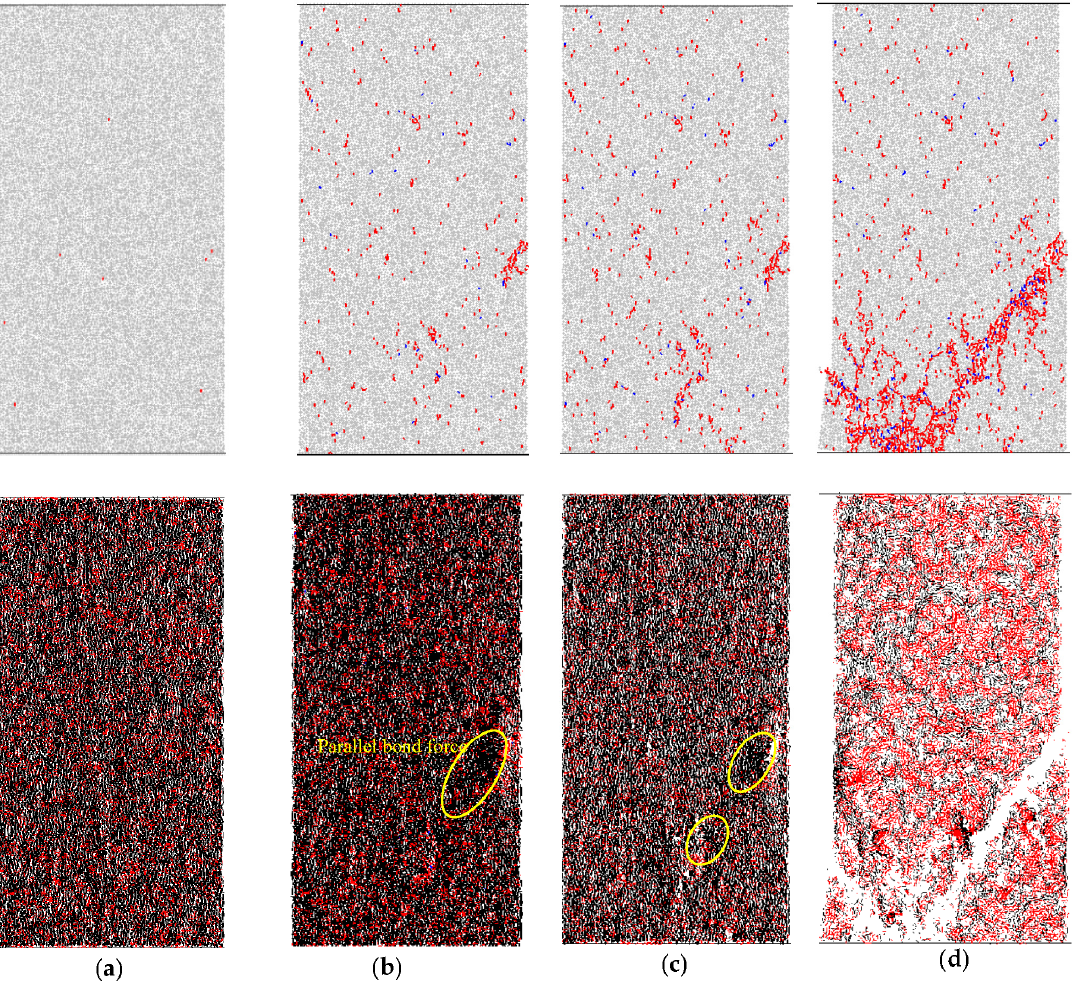
Figure 9. Crack evolution process and parallel bond force field of the granite specimen at 100 °C: ( a ) ε 1 = 1.25 × 10 − 2 , σ 1 = 112.07 MPa; ( b ) ε 1 = 2.18 × 10 − 2 , σ 1 = 192.81 MPa; ( c ) ε 1 = 2.36 × 10 − 2 , σ 1 = 205.63 MPa; and ( d ) ε 1 = 2.56 × 10 − 2 , σ 1 = 1.75 MPa.